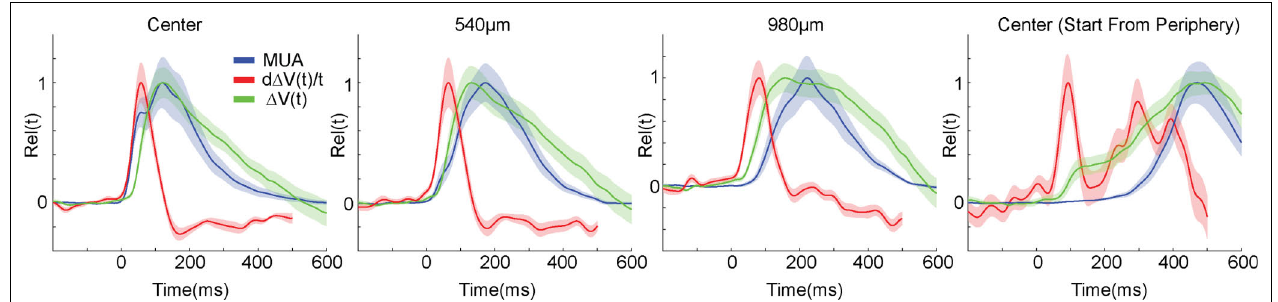
and downwards movement conditions were pooled as in Figure 3 . Shaded areas indicate the SEM. At the cortical point representing the CFOV, the d( Δ V ( t ))/ d t rel( t ) (the inward current in the S layers) follows the MUA rel( t ) with a lag of a few ms up to 70 ms. At 540 µm the MUA rel( t ) does not appear to drive the d( Δ V ( t ))/d t rel( t ). At 980 µm the Δ V ( t ) rel( t ) leads the MUA rel( t ) by some 200 ms. Center (Start from periphery): same variables measured for the bar starting in the peripheral FOV at the retinotopic point of